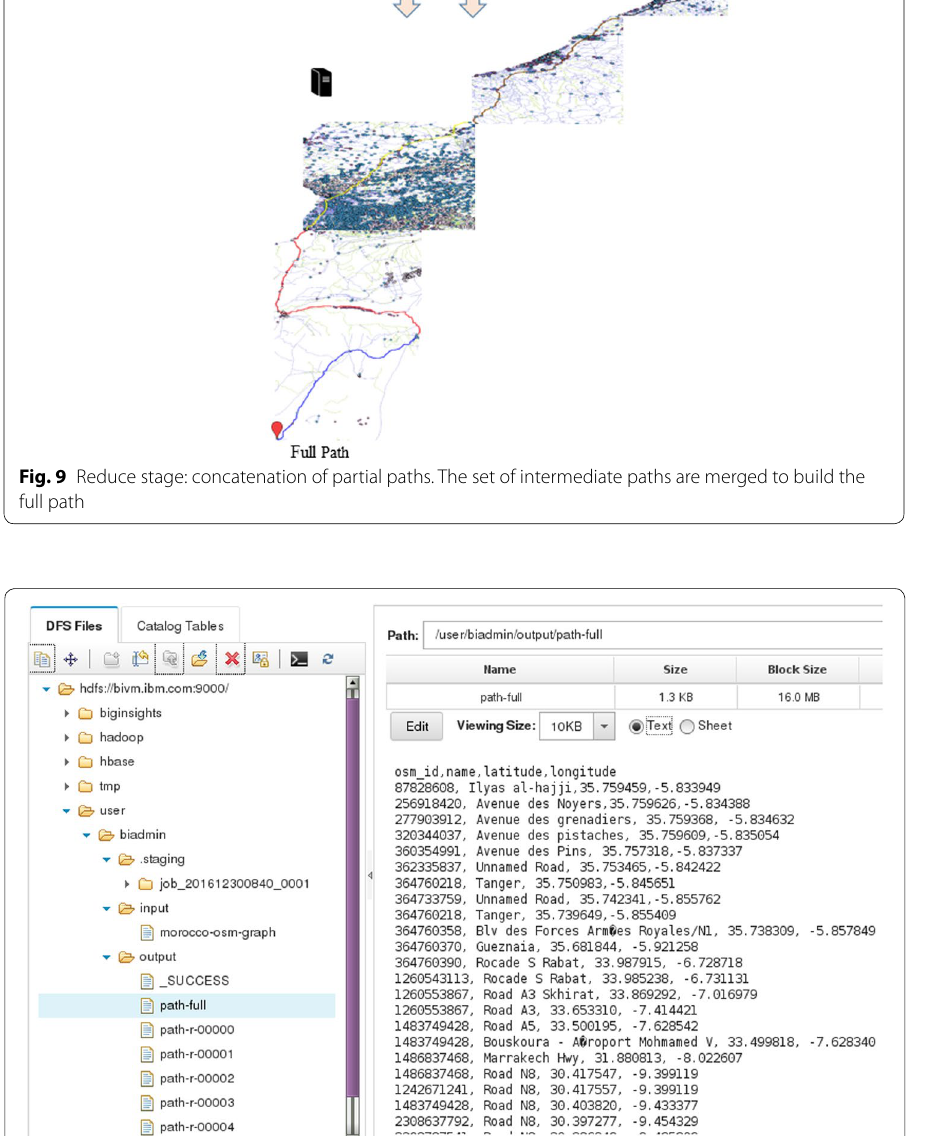
Fig. 10 Output stage: writing of the full paths. The full path solution is uploaded to the distributed file system, the user can visualize the solution via the HDFS